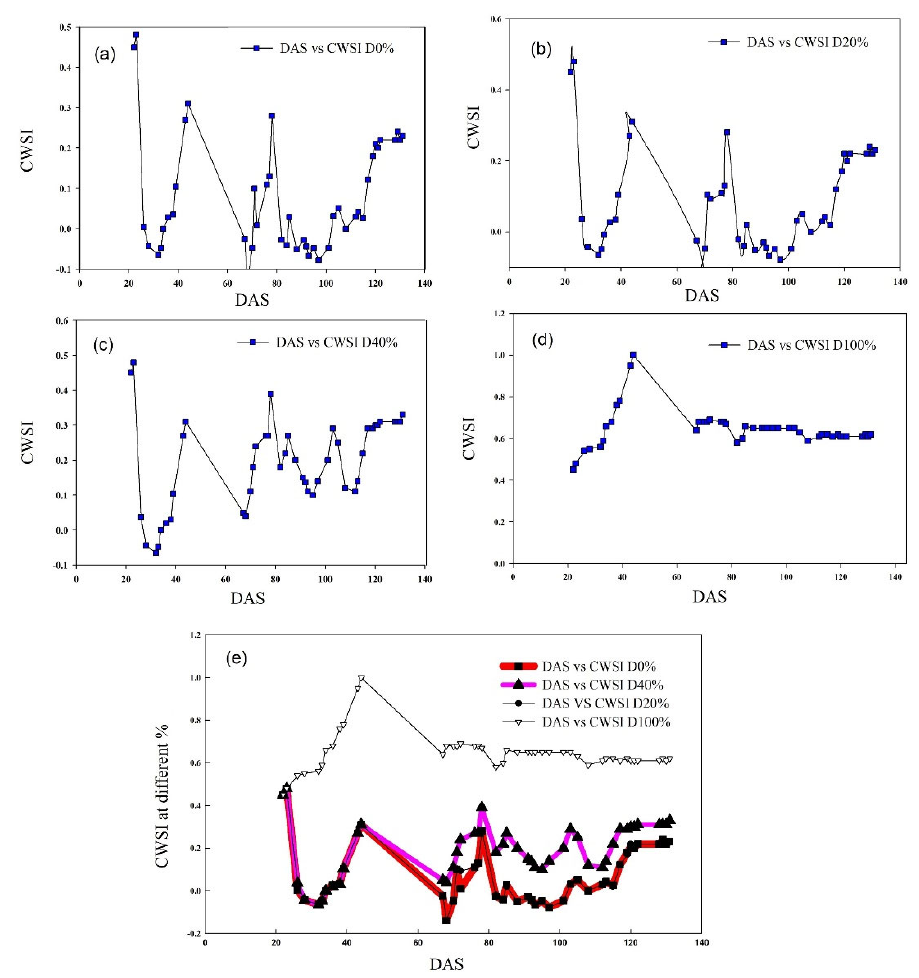
Figure 5. Relationship between DAS and CWSI for different irrigation deficit treatments ( a ) at D0%, ( b ) at D20%, ( c ) at D40%, and ( d ) at D100%; ( e ) combined trend of all deficit levels. ( b ) at D 20% , ( c ) at D 40% , and ( d ) at D 100% ; ( e ) combined trend of all deficit